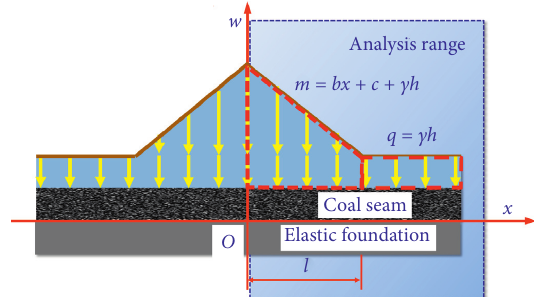
Figure 2: A typical mechanical model of the coal seam pressurised by a